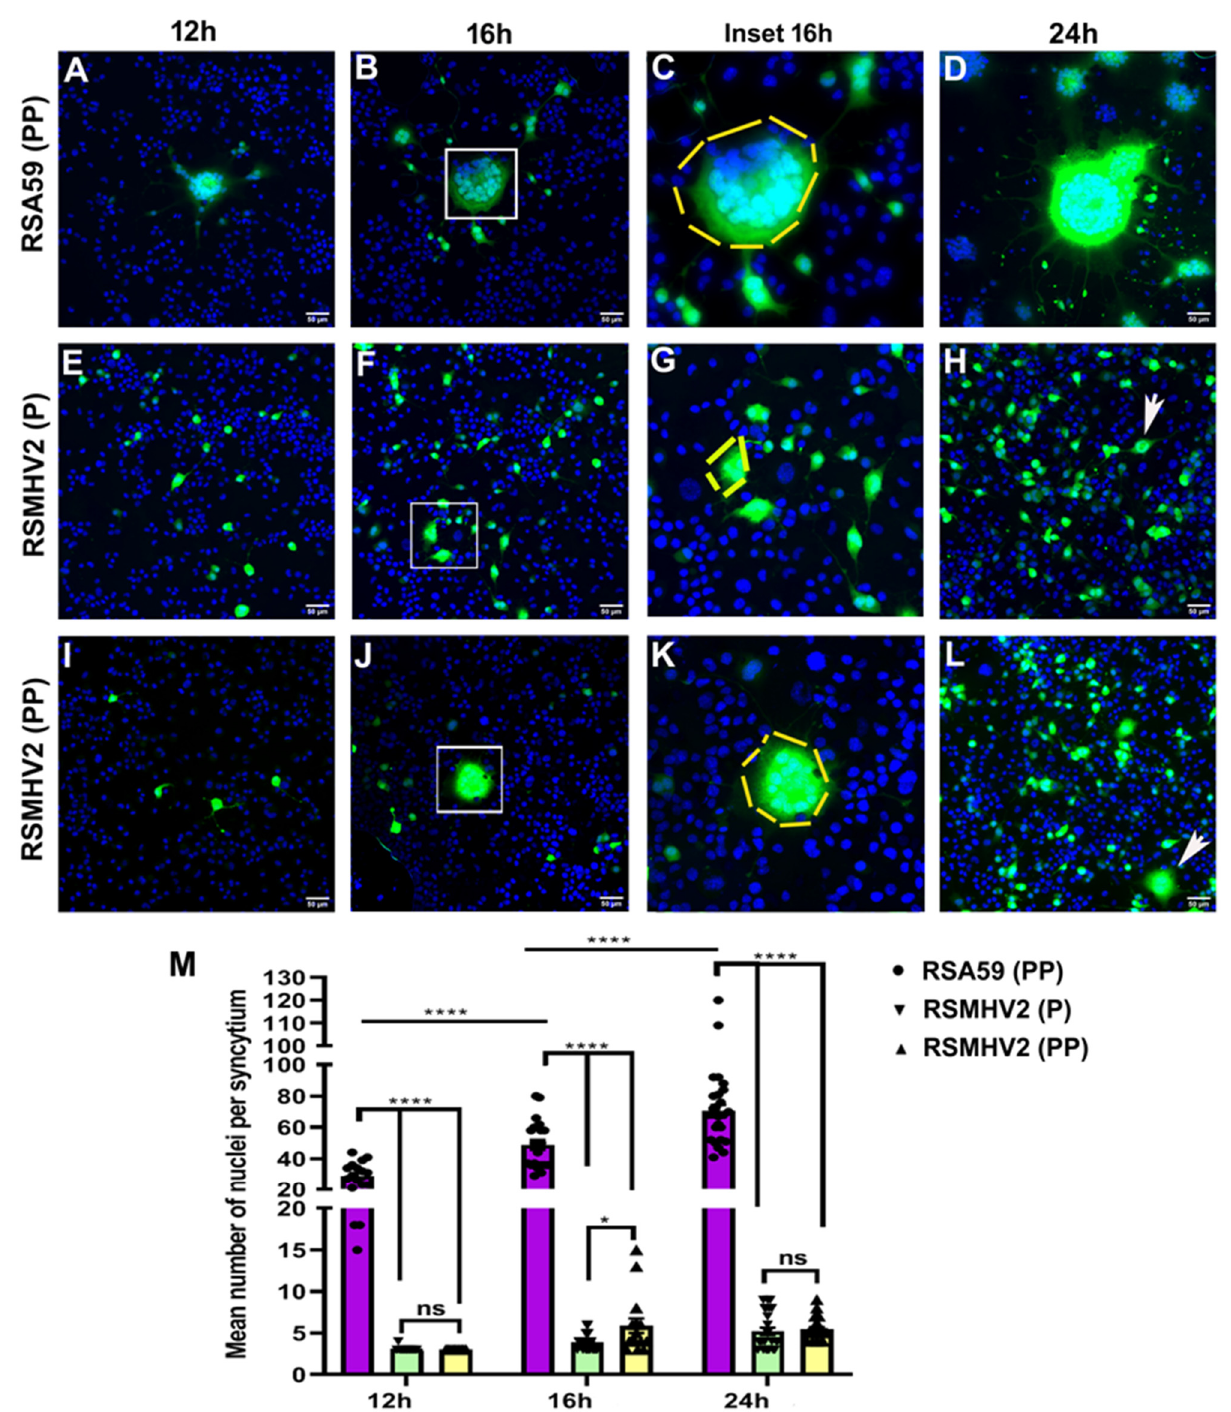
Figure 3. Comparison of syncytia formation in Neuro2a cell infected by RSA59 (PP), RSMHV2 (P), and the one proline added mutant RSMHV2 (PP). Neuro2a cells were infected with RSA59 (PP), RSMHV2 (P), and RSMHV2 (PP) at 0.5 MOI. The green fluorescence is due to EGFP that is integrated into the viral genome. Images of DAPI (Blue) and EGFP (Green) were merged to construct the final images presented here; ( A – D ) panels are from RSA59 (PP) infected Neuro2a cells at 12 h ( A ) 16 h, ( B ), and ( C ) is a magnified image of 16 h, ( D ) at 24 h, respectively. Panel E-H shows